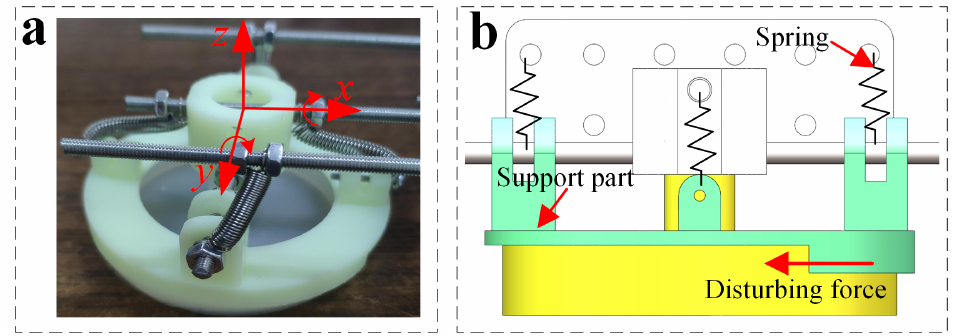
Figure 9. The structure of robot’s foot. ( a ) The adhesion actuator can rotate around the x -axis and y -axis; ( b ) illustration of the disturbing force of the support part (green) to adhesion actuator (yellow). Since the initial volume of the cavity is changed in the pre-tensioning phase, the initial volume of the cavity determines the maximum shear adhesion force that the actuator can by controlling the height of the cavity, thereby controlling the maximum shear adhesion force. The relationship between the cavity height change of the actuator and the maximum